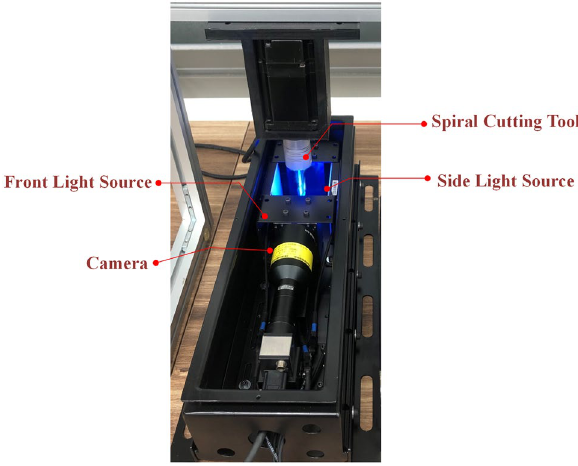
Figure 4. The developed optical instrument of tool wear monitoring system.